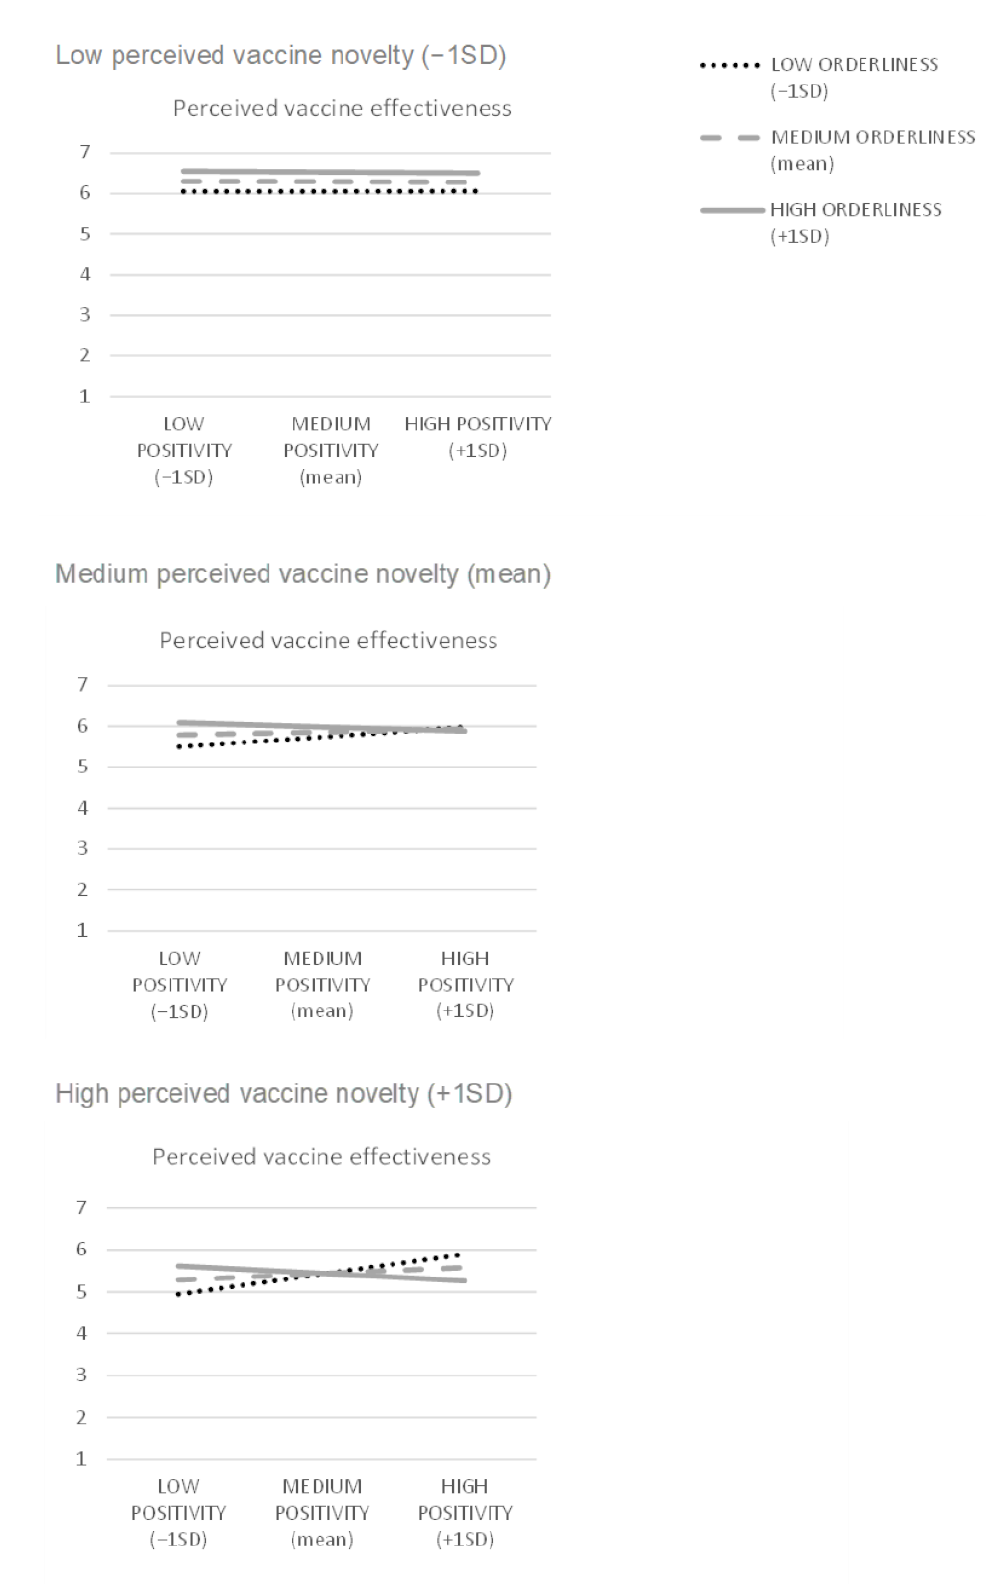
Figure 7. Visualization of conditional effects of belief in the world’s positivity on perceived vaccine effectiveness (belief in the world’s orderliness and perceived vaccine novelty are the